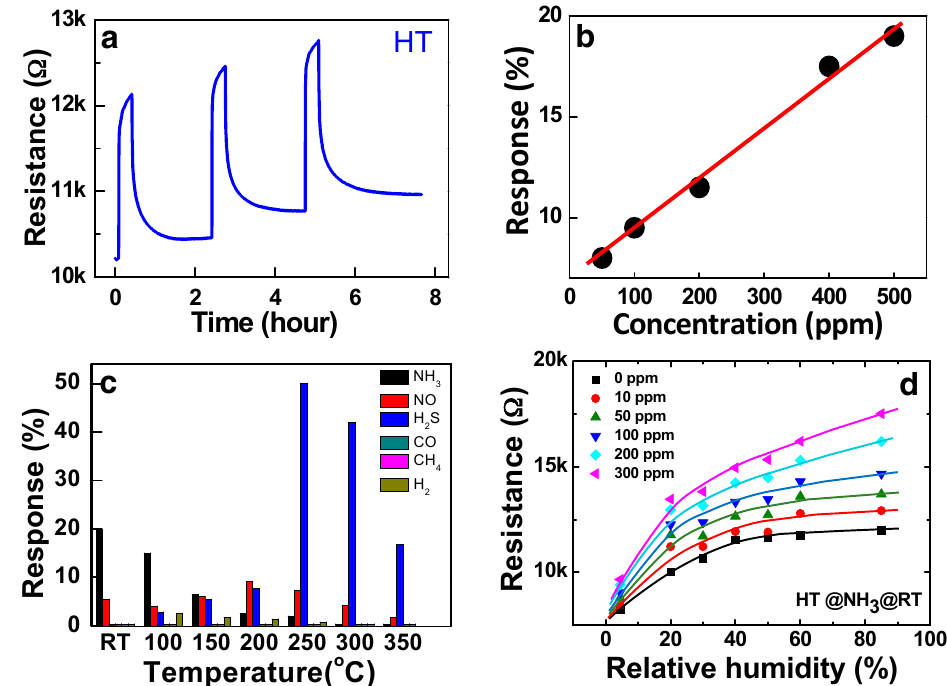
Figure 9. ( a ) Sensing reproducibility of the HT sample showing good repeatability but with increasing baseline resistance for 500 ppm NH 3 concentration at RT or ~25 °C. ( b ) Linearity of HT measured in the concentration range between 50 and 500 ppm NH 3 at RT. ( c ) Gas selectivity of HT tested at various temperatures for each of the 500 ppm concentrations. ( d ) Humidity dependent resistance of HT measured at RT under varying NH 3 concentration and RH.